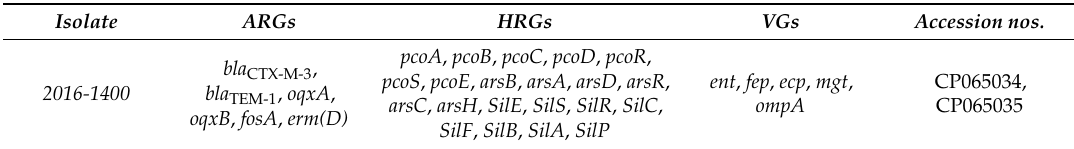
Table 3. Genes for antibiotic resistance, heavy metal resistance and virulence identified in K. pneumoniae isolate 2016-1400.